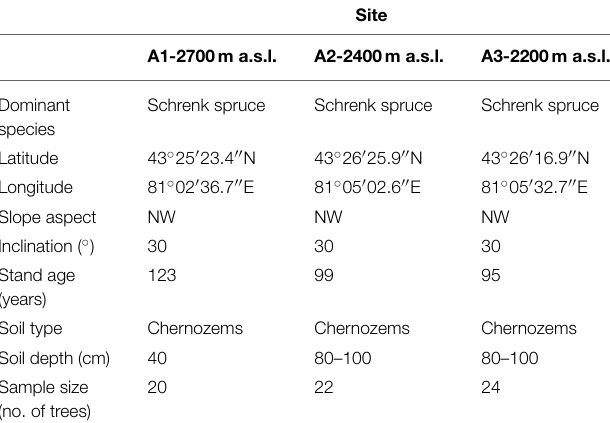
TABLE 1 | Site descriptions for the three sites used to obtain the three tree-ring